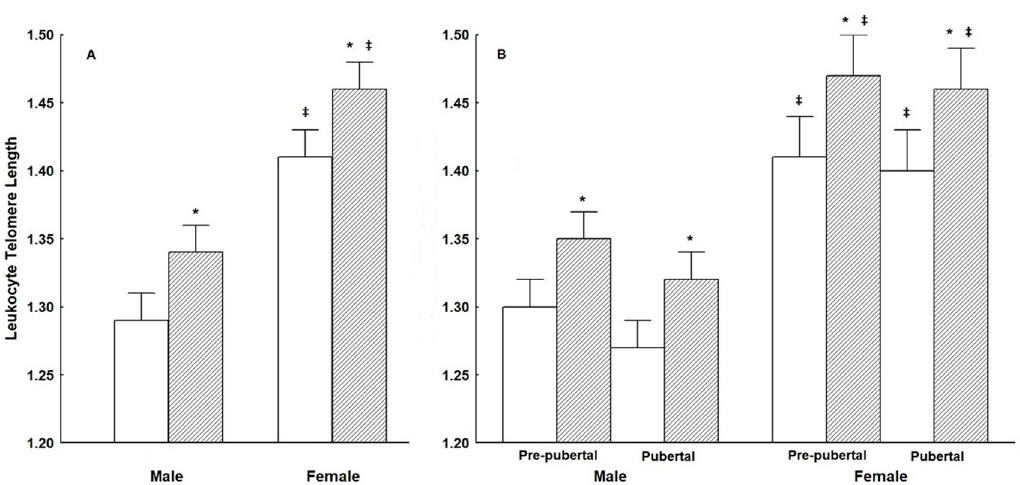
Figure 1. Panel ( A ): leukocyte telomere length (LTL) (mean ± SE) of male and female subjects with “good compliance” ( n = 407), at initial assessment (white bars) and at 12 months (shaded bars). Panel ( B ): leukocyte telomere length (LTL) of male and female, prepubertal, and pubertal at initial assessment subjects with “good compliance” ( n = 407), at initial assessment (white bars) and at 12 months (shaded bars). All measured variables were compared by employing repeated-measures ANOVA. Significant main effects were revealed by LSD post-hoc test. Statistical significance was set at ( p < 0.05). * Indicates significant difference between initial assessment and the 12 months follow-up, time-points; ‡ Indicates significant difference from the Male group.